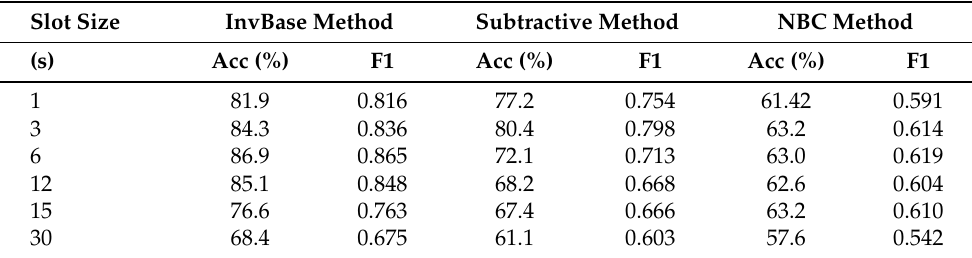
Table 2. Arousal classification accuracies and F1 scores of InvBase, subtractive, and NBC methods using MLP for various slot sizes.